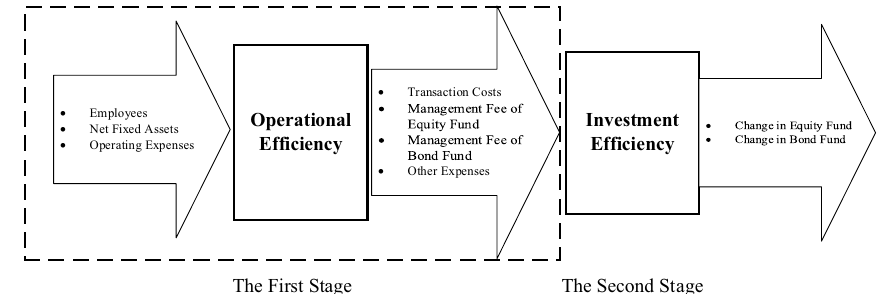
Fig. 1 The two‑stage production process of investment trust